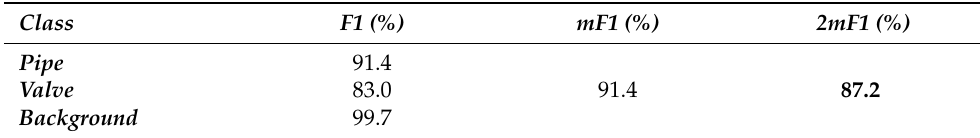
Table 3. DGCNN pixel-level metrics on T EXTRA test